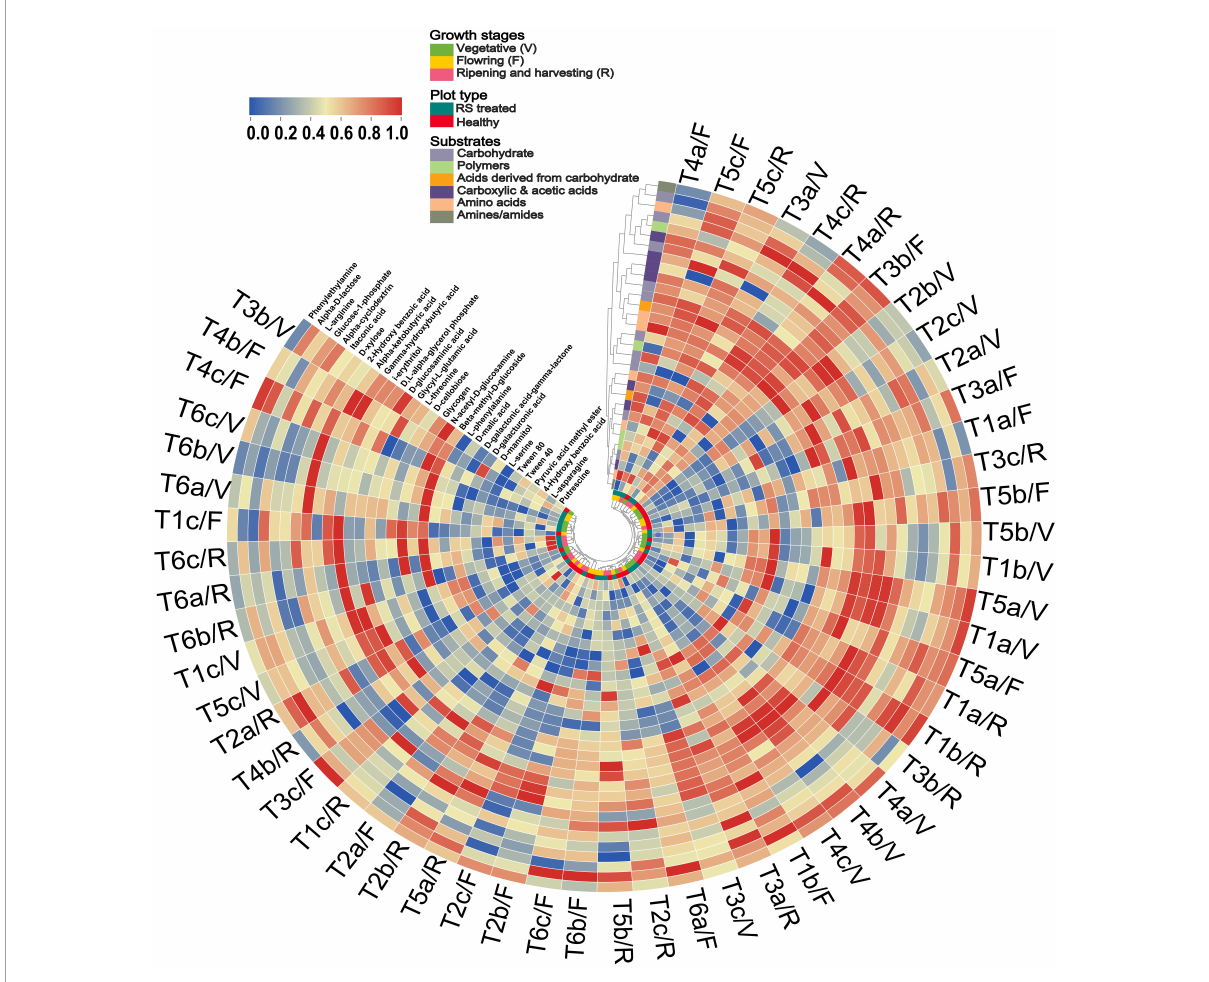
FIGURE4 Circular heat map and hierarchical cluster analysis based on the average well color development (AWCD) at 120 h of soil microbial communities under pathogen and antagonist treated soil. Higher to low AWCD response indicated via red to blue gradient. Treatment details as Figure 2